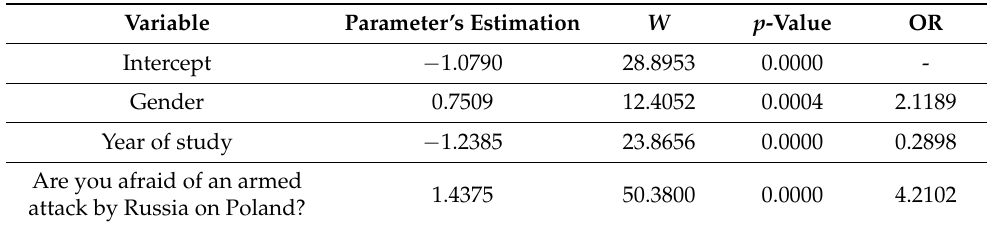
Table 4. Logit model parameter evaluations.